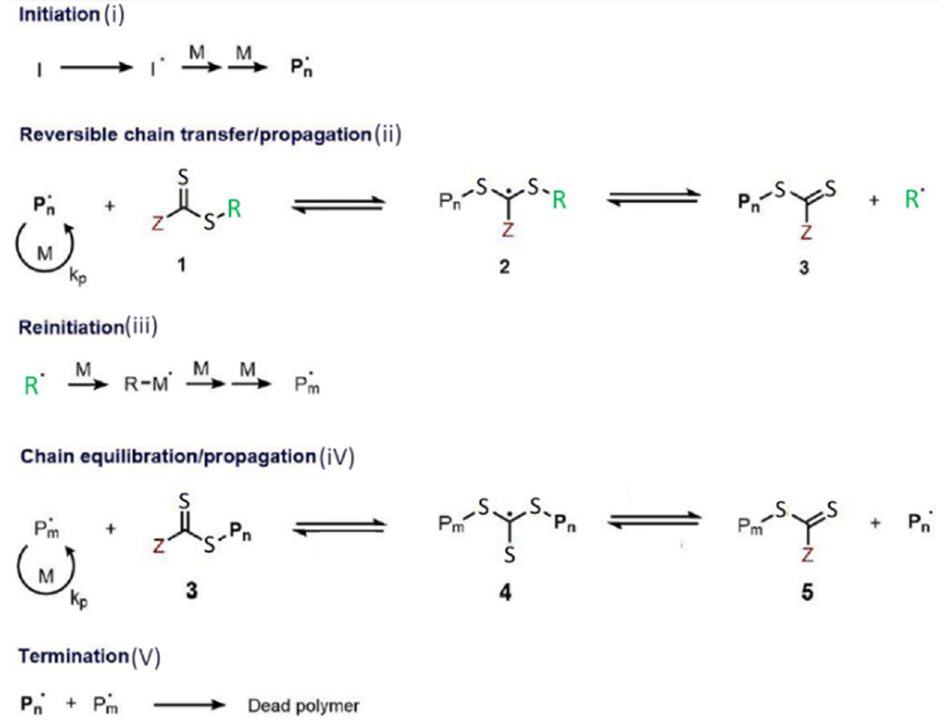
Figure 13. General mechanism of RAFT polymerization (slightly modified from ref. [156]) .